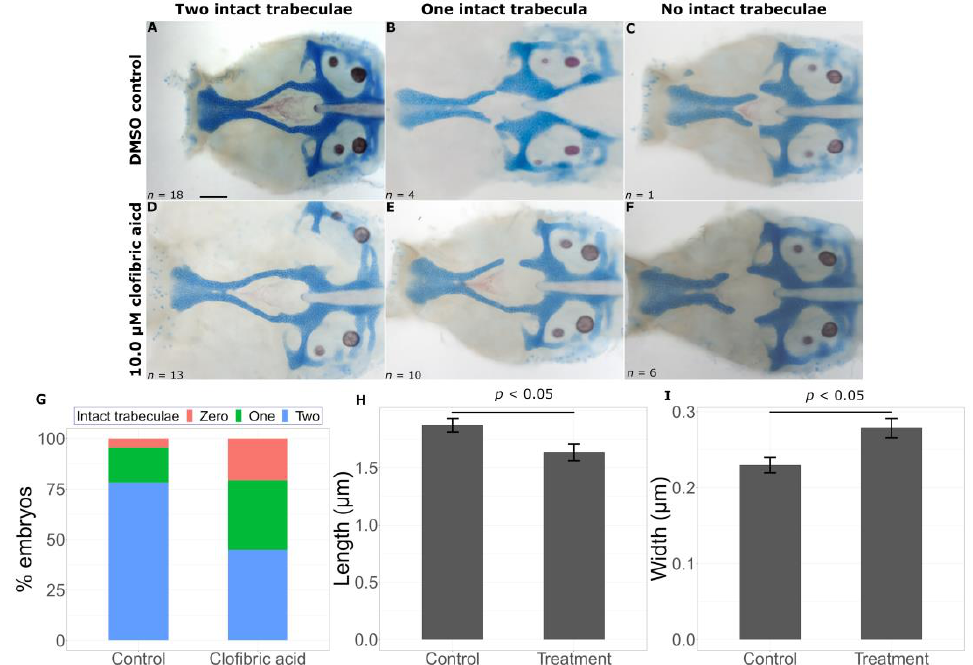
Figure 6. Clofibric acid worsens the gata3 mutant phenotype. Representative flat mounts show defects in the trabeculae with DMSO treatment ( A – C ) and chemical treatment ( D – F ). Clofibric acid treatment leads to a statistically significant decrease in intact trabeculae count (( G ), p < 0.05), a reduction in trabeculae length (( H ), p < 0.05), and an increase in trabeculae width (( I ), p < 0.05). Error bars represent SEM. Scale bar = 0.5 μ m.